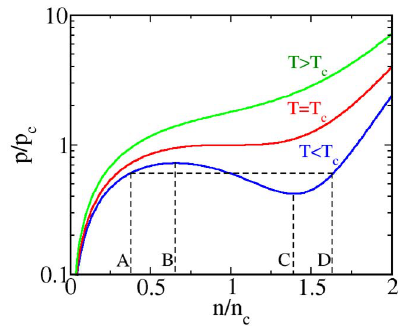
Figure 5. Schematic pressure isotherms as functions of the density at a liquid–vapor-like phase transition. P c , n c and T c are the pressure, density and temperature at the critical point.